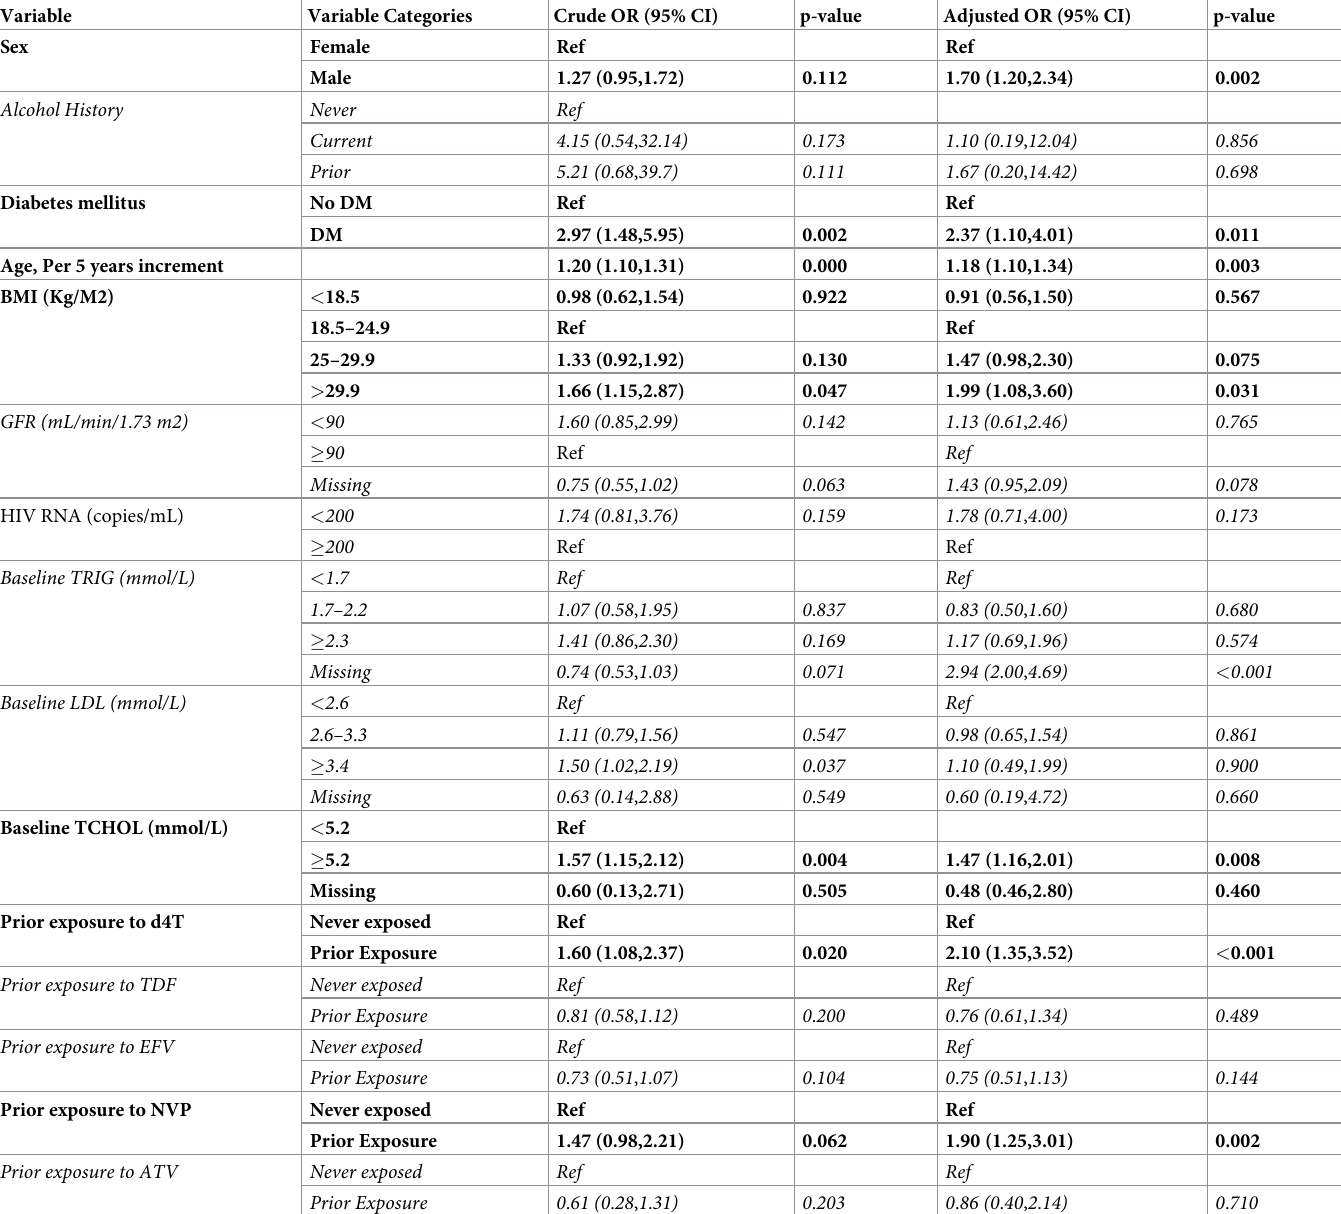
Table 2. Factors associated with prevalent hypertension in the ALT cohort at baseline (n =